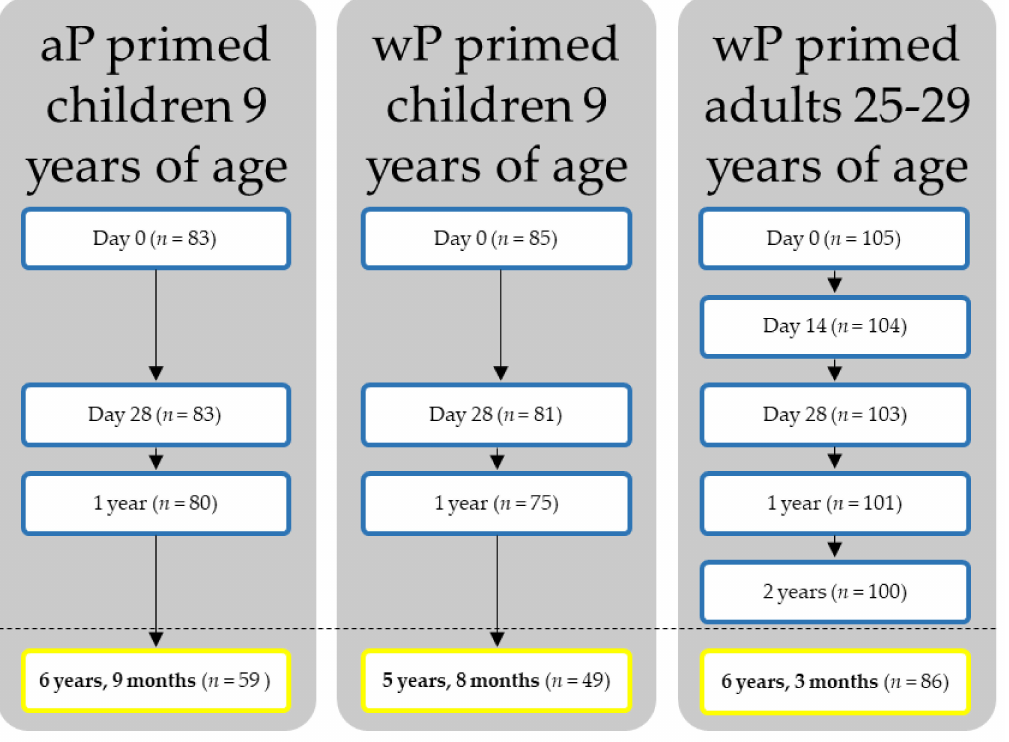
Figure 1. Flow scheme. aP: acellular pertussis; wP: whole cell